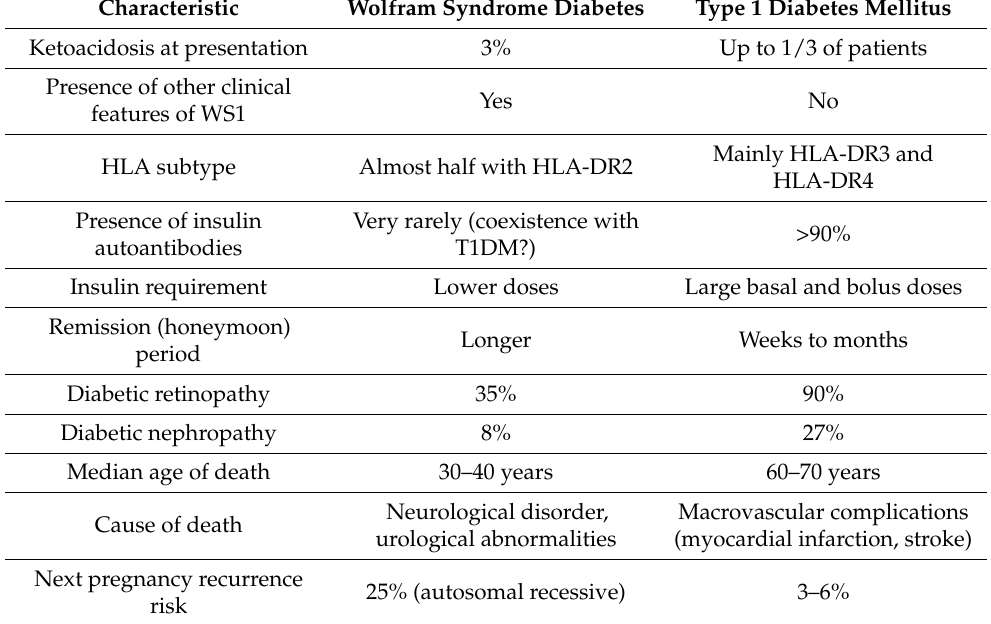
Table 2. Differences between Wolfram syndrome 1 diabetes and type 1 diabetes mellitus [18,43,47–49].